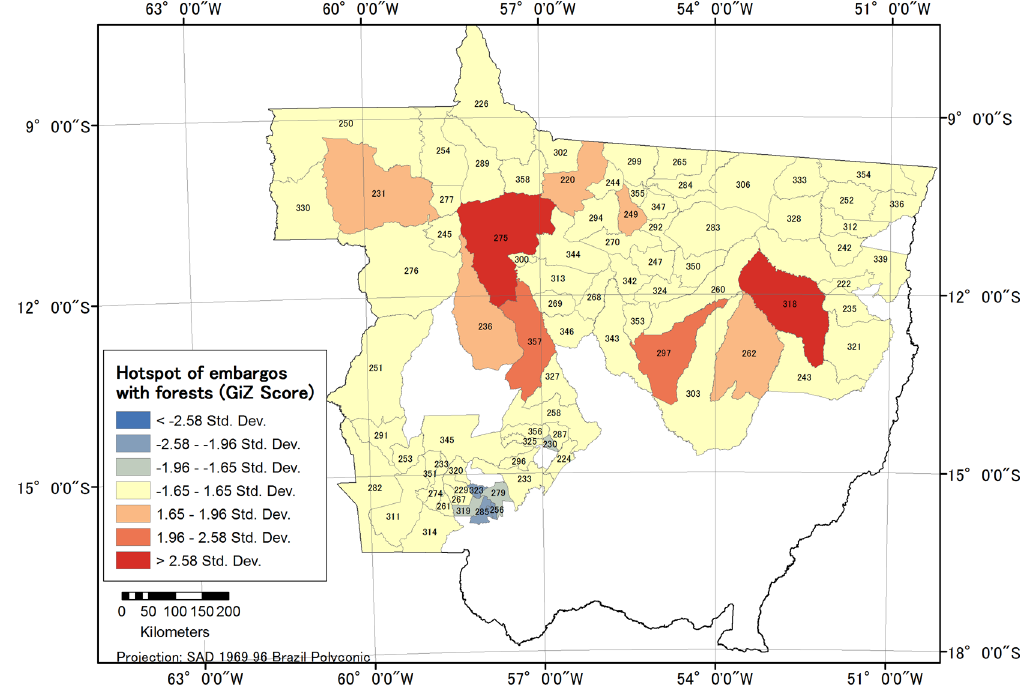
Figure 6. Hot spot map of embargoed properties with remaining forest.